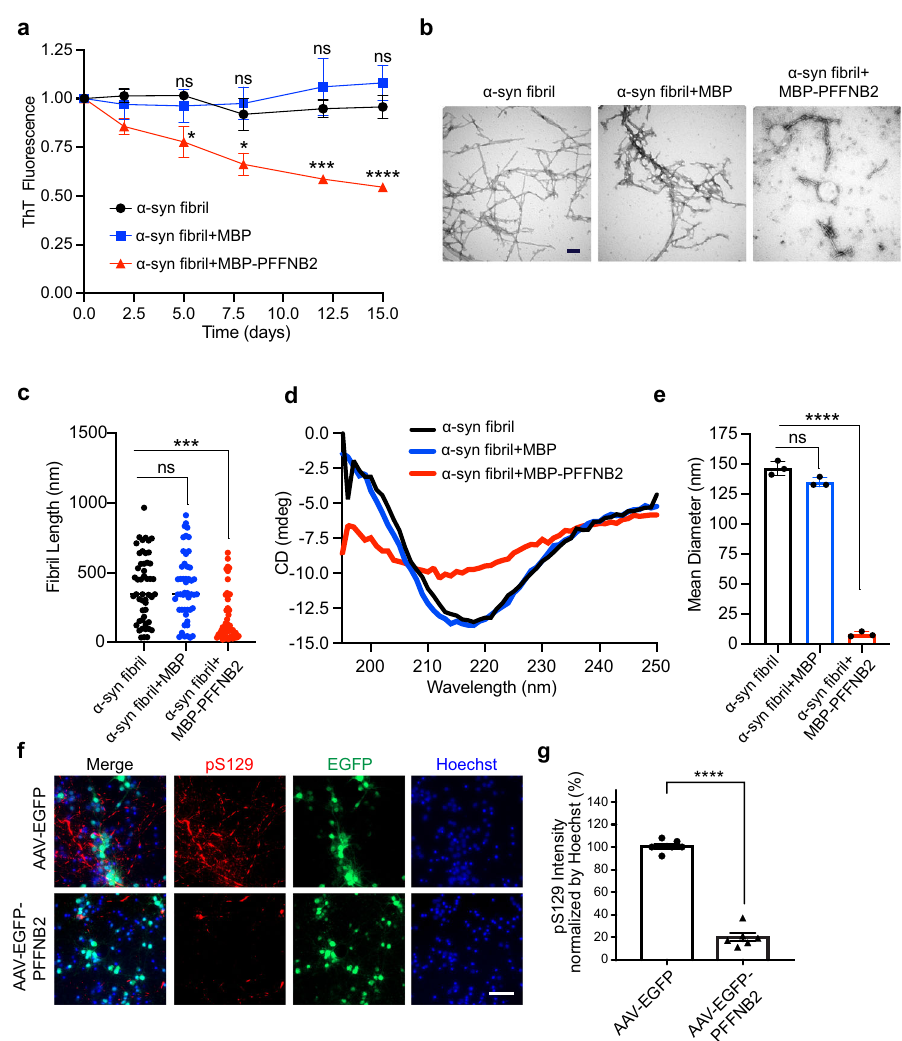
Fig. 3 PFFNB2 dissociates α -syn fi brils and inhibits α -syn pathology induced by PFF in vitro. a Disaggregation of α -syn fi brils monitored by ThT fl uorescence assay. α -syn PFF was incubated alone (black), with MBP-PFFNB2 (red), or with MBP (blue). Quanti fi cation data are the means ± SEM, n = 3 independent experimental replicates, two-way ANOVA with Tukey correction. ( α -syn fi brils vs. α -syn fi brils + MBP-PFFNB2, P values are Day5 = 0.0388, Day8 = 0.0199, Day12 = 0.0005, Day15 = 0.0001) * P < 0.05, ** P < 0.01, *** P < 0.001, ns, not signi fi cant. b TEM images of α -syn fi brils with MBP-PFFNB2 or MBP. Scale bar, 100 nm. c Quanti fi cation of fi bril length from ( b ). Quanti fi cation data are the means ± SEM, n = 50 datapoints per group, one-way ANOVA with Tukey correction. ( α -syn fi brils vs. α -syn fi brils + MBP-PFFNB2, P = 0.0001) *** P < 0.001, ns, not signi fi cant ( d ) Circular dichroism (CD) spectra for α -syn PFF with MBP-PFFNB2 or MBP. e Dynamic light scattering (DLS) analysis for α -syn fi brils with MBP-PFFNB2 or MBP. Quanti fi cation data are the means ± SEM, n = 3 independent experiments, P values were determined by one-way ANOVA with Tukey correction. ( α -syn fi brils vs. α -syn fi brils + MBP-PFFNB2, P = 0.0001). **** P < 0.0001, ns, not signi fi cant. f WT mouse primary cortical neurons were transduced with AAV encoding EGFP (control group) or EGFP-PFFNB2 (PFFNB2 group) at day 5 in vitro and α -syn PFF at day 7 in vitro. The α -syn pathology level was assessed with anti-phosphorylated serine129 (pS129) immunostaining 7 days after α -syn PFF treatment. Scale bar, 50 μ m. g Quanti fi cation of the pS129 immunoreactivity normalized by Hoechst. Quanti fi cation data are the means± SEM, n = 6 independent experiments, P values were determined by two-sided Student ’ s t test. (AAV-EGFP vs. AAV-EGFP-PFFNB2 P = 0.0001). **** P < 0.0001. Source data are provided as a Source Data fi